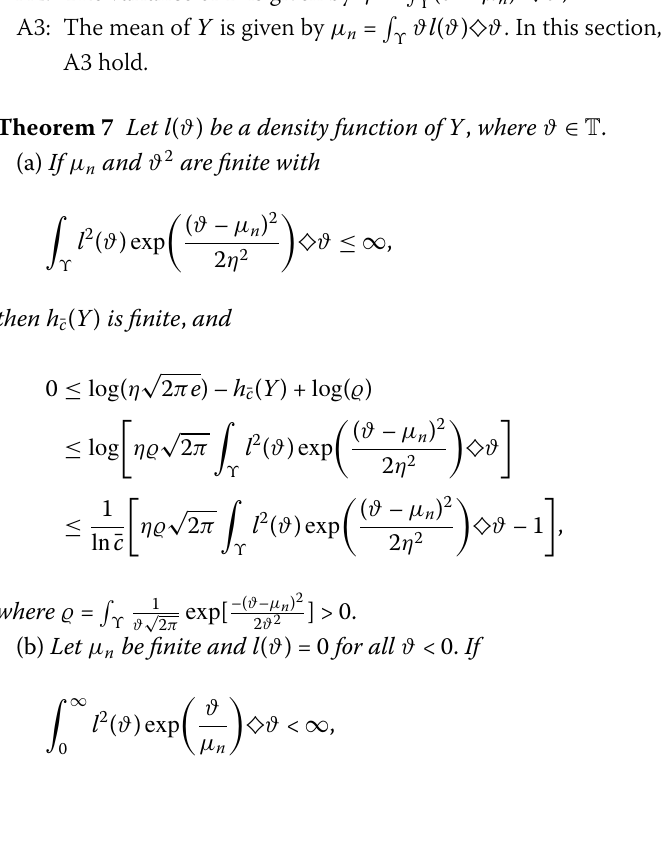
4 Entropy of continuous random variable via diamond integrals